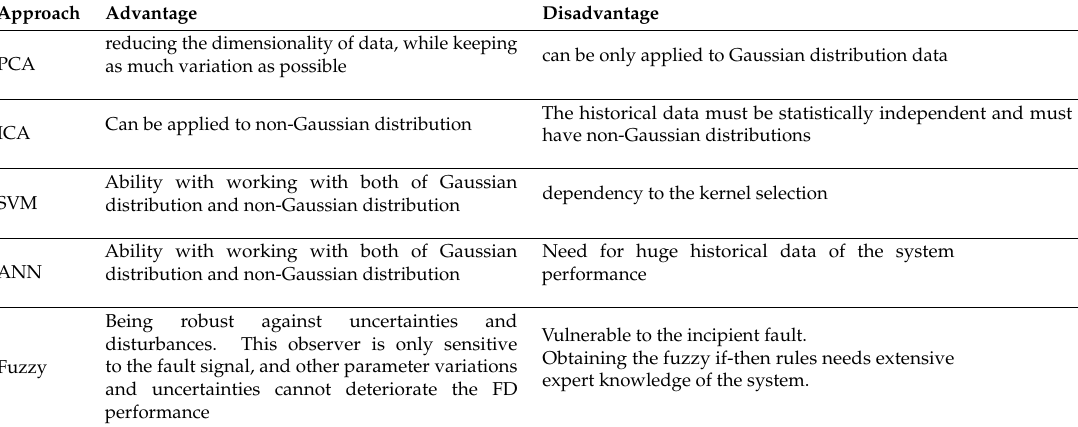
Table 2. Summarizing the advantages and disadvantages of the Knowledge-based FDI